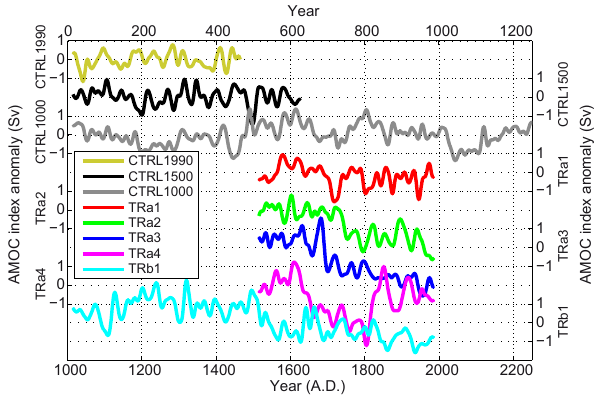
Fig. 4. Low-pass filtered time series of the AMOC index. The time series of the control integrations show the anomaly from their mean, while the time series of the transient simulations are calcu- lated as the anomaly from the mean of the initializing control ex- periment. The upper abscissa indicates the model years for the con- trol simulations and the lower abscissa corresponds to the transient simulations.